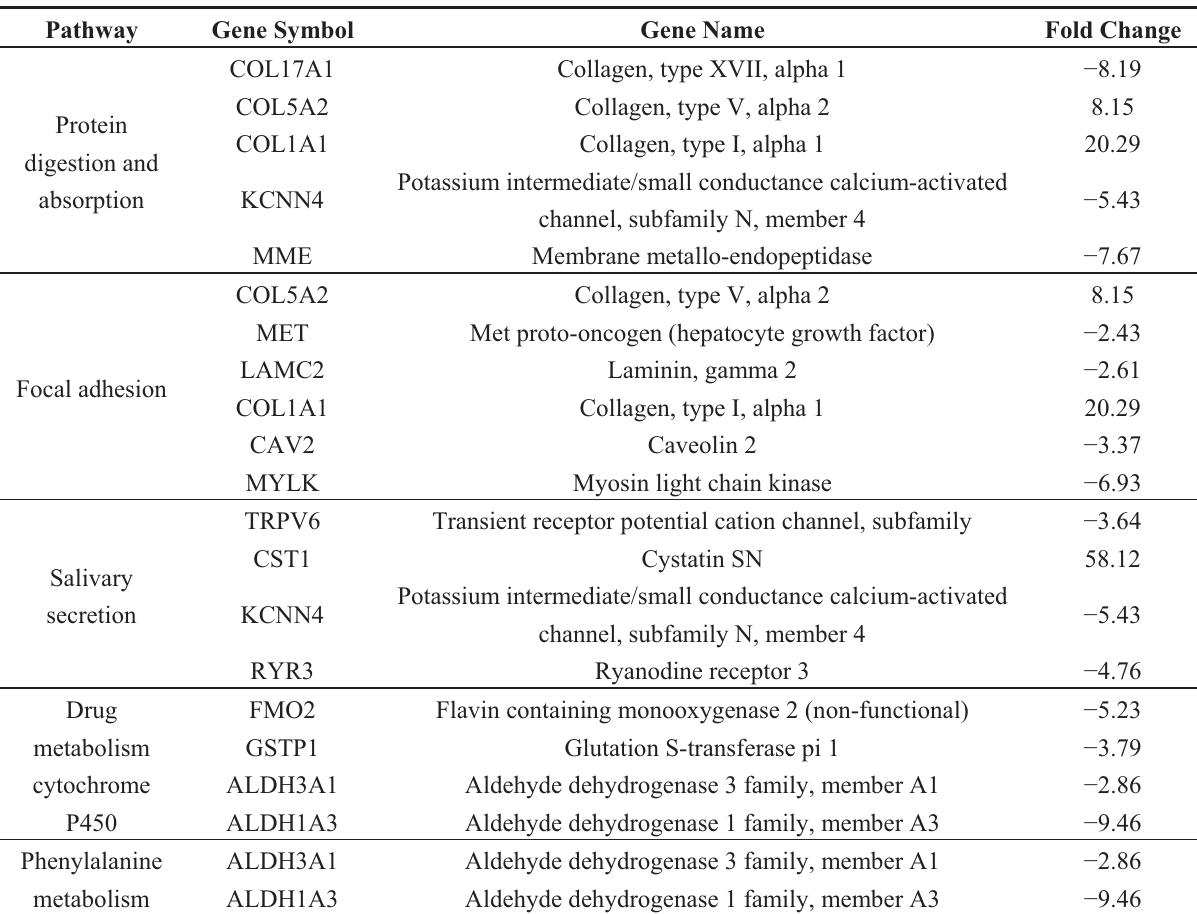
Table 6. KEGG pathway analysis of DEGs and their fold changes in microarray